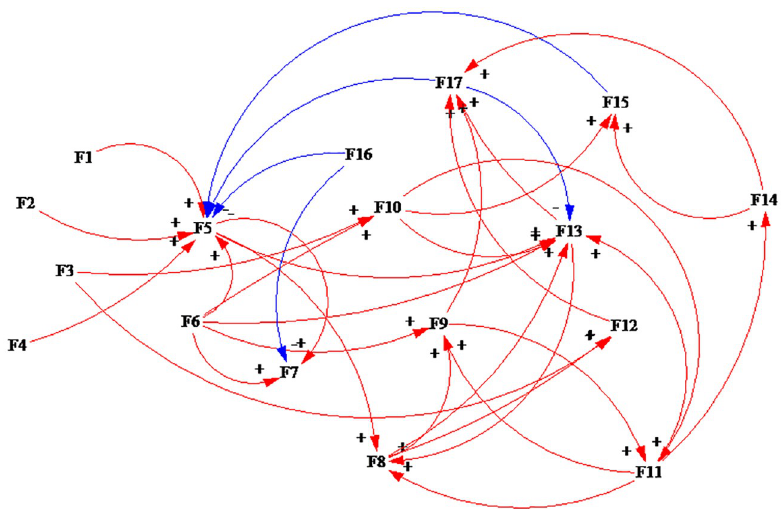
Fig 1. The interaction among the elements of the HATCs in a safe